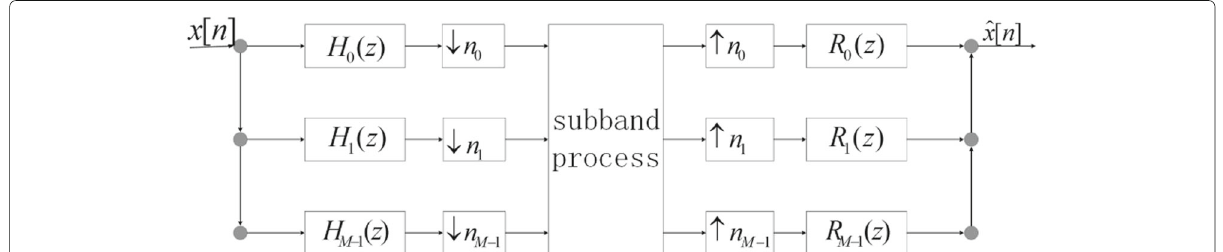
Fig. 1 Non-uniform filter banks. The terms H k ( z ) and R k ( z ) correspond to the z-transforms of the k th filter and dual filter, i.e., H k ( z ) = z − l k for some integers l k and R k ( z ) = z l